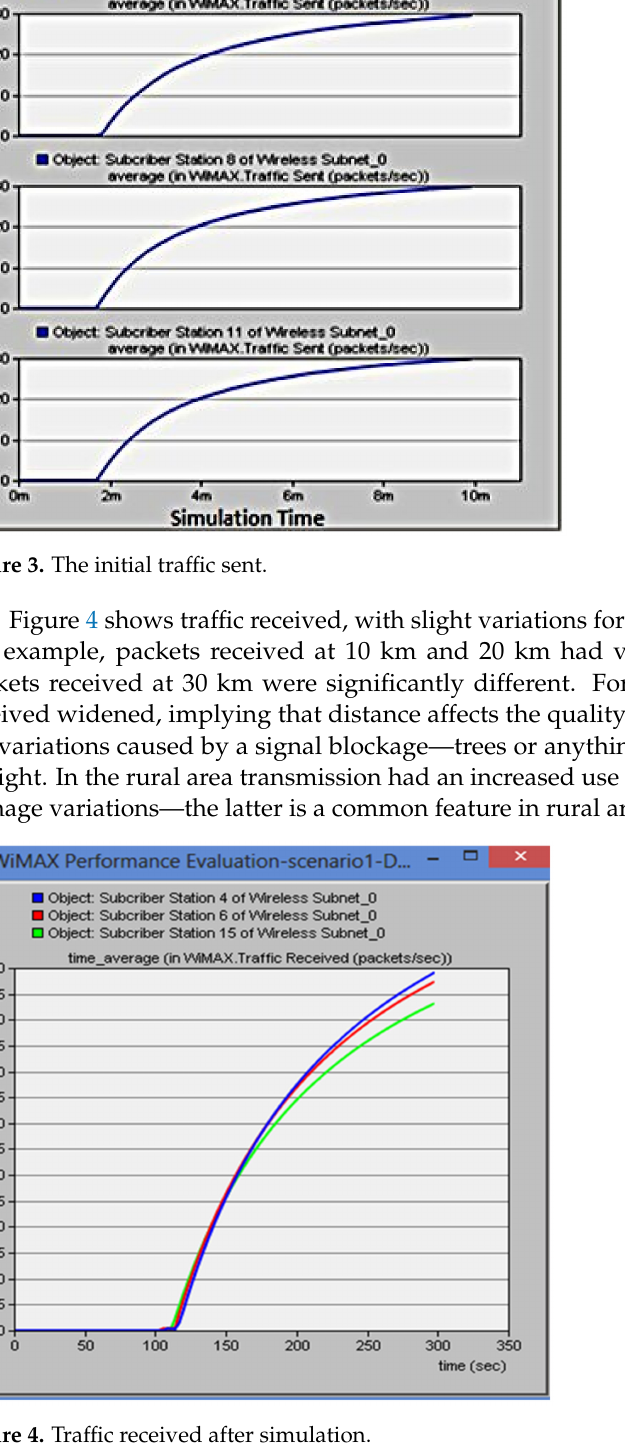
Figure 4. Traffic received after